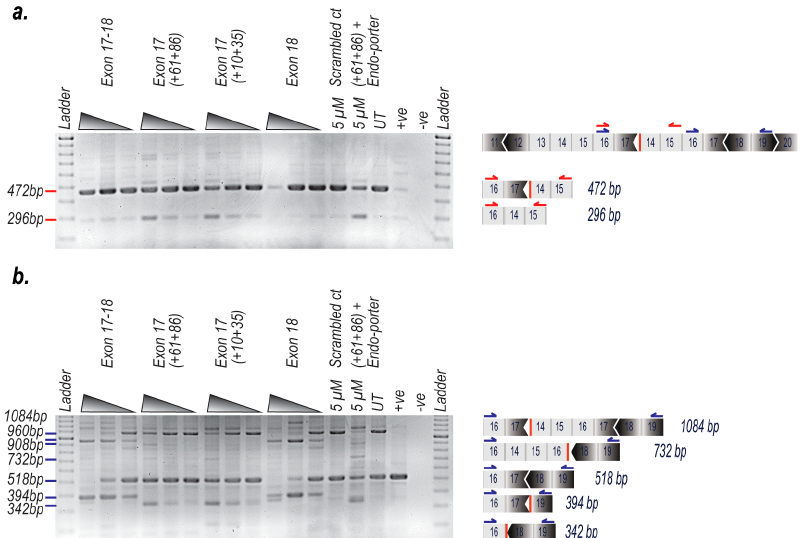
Figure 3. PCR analysis to determine specific AO-induced excision of dystrophin exons 17–18 from a